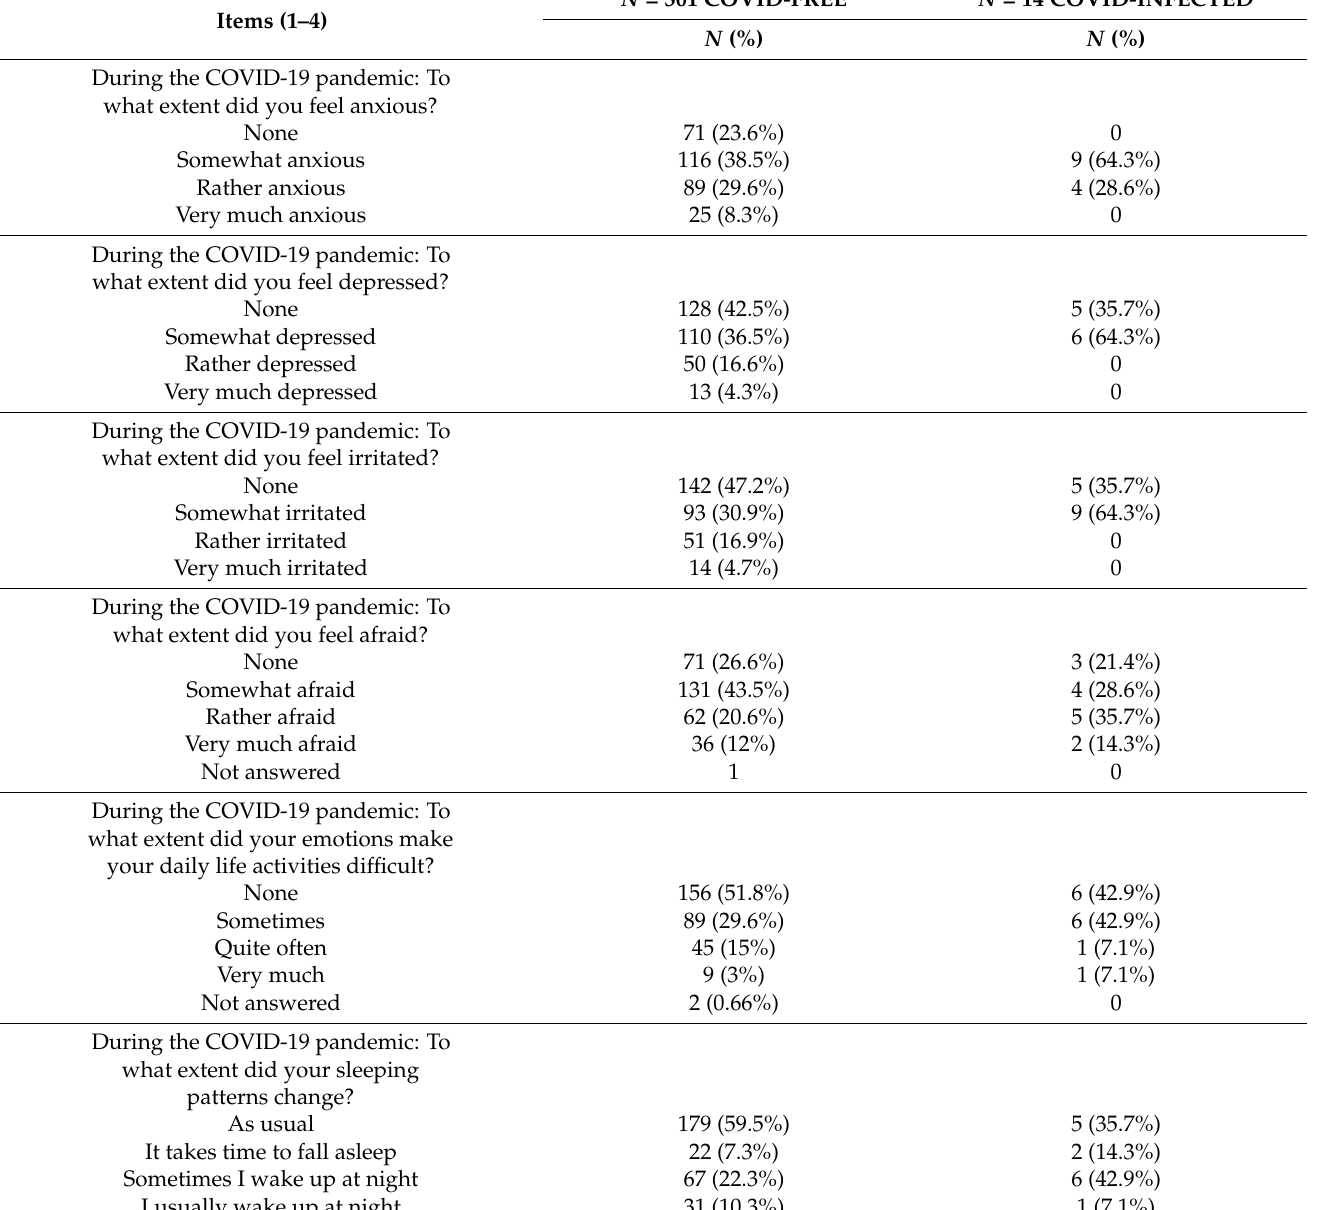
Table 4. Feelings and emotions during the COVID19